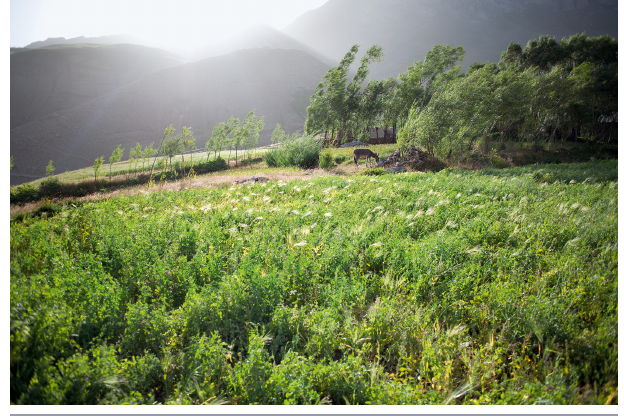
To the Pamiri cook and farmer, the function of lashak-makh is broader still. They use the harvest from these fields to make a flour called hazorza, which means “mix of a thousand.” The crops are not separated, but harvested and milled together, and the hazorza flour is used to make bread or a nutritious noodle soup called osh, which is rich in protein and energy and has a cooling quality when eaten while working the fields in summer. Many kinds of osh exist, made with different mixed flours that come from different combinations of crops grown at different altitudes, and many songs and poems are recited about osh. The soup and the cultivation system are interlinked; the agronomic utility of the cultivation system is connected to the nutritional and cultural utility of hazorza and osh and is strengthened by it.